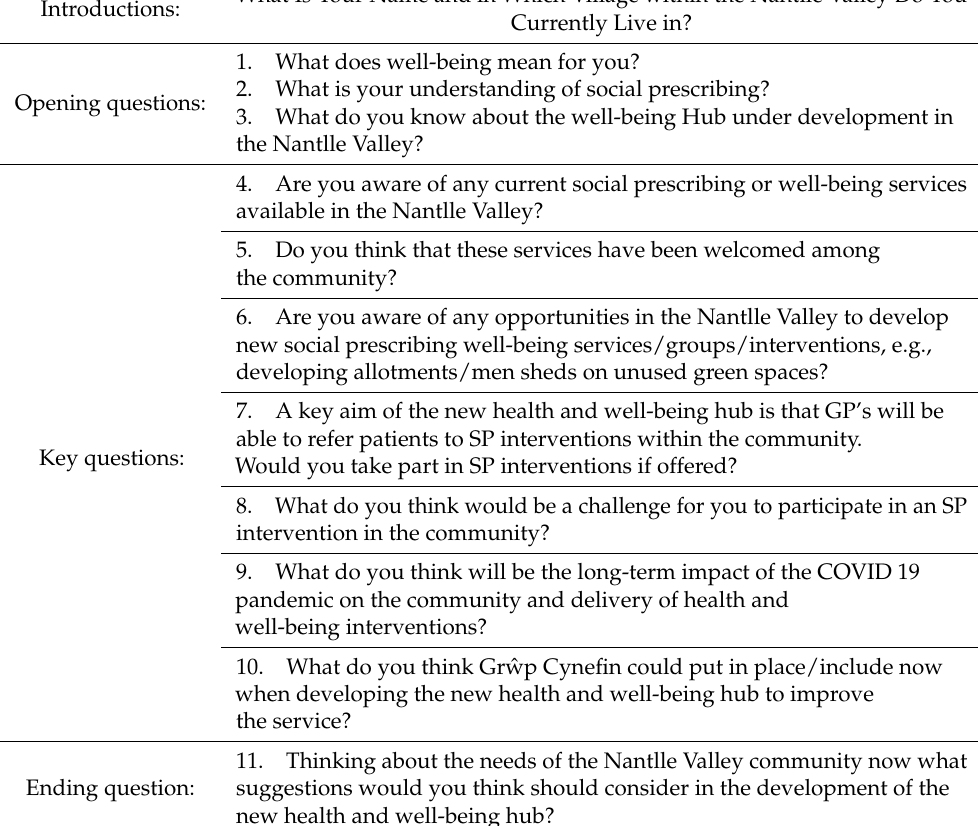
Table 3. Today group